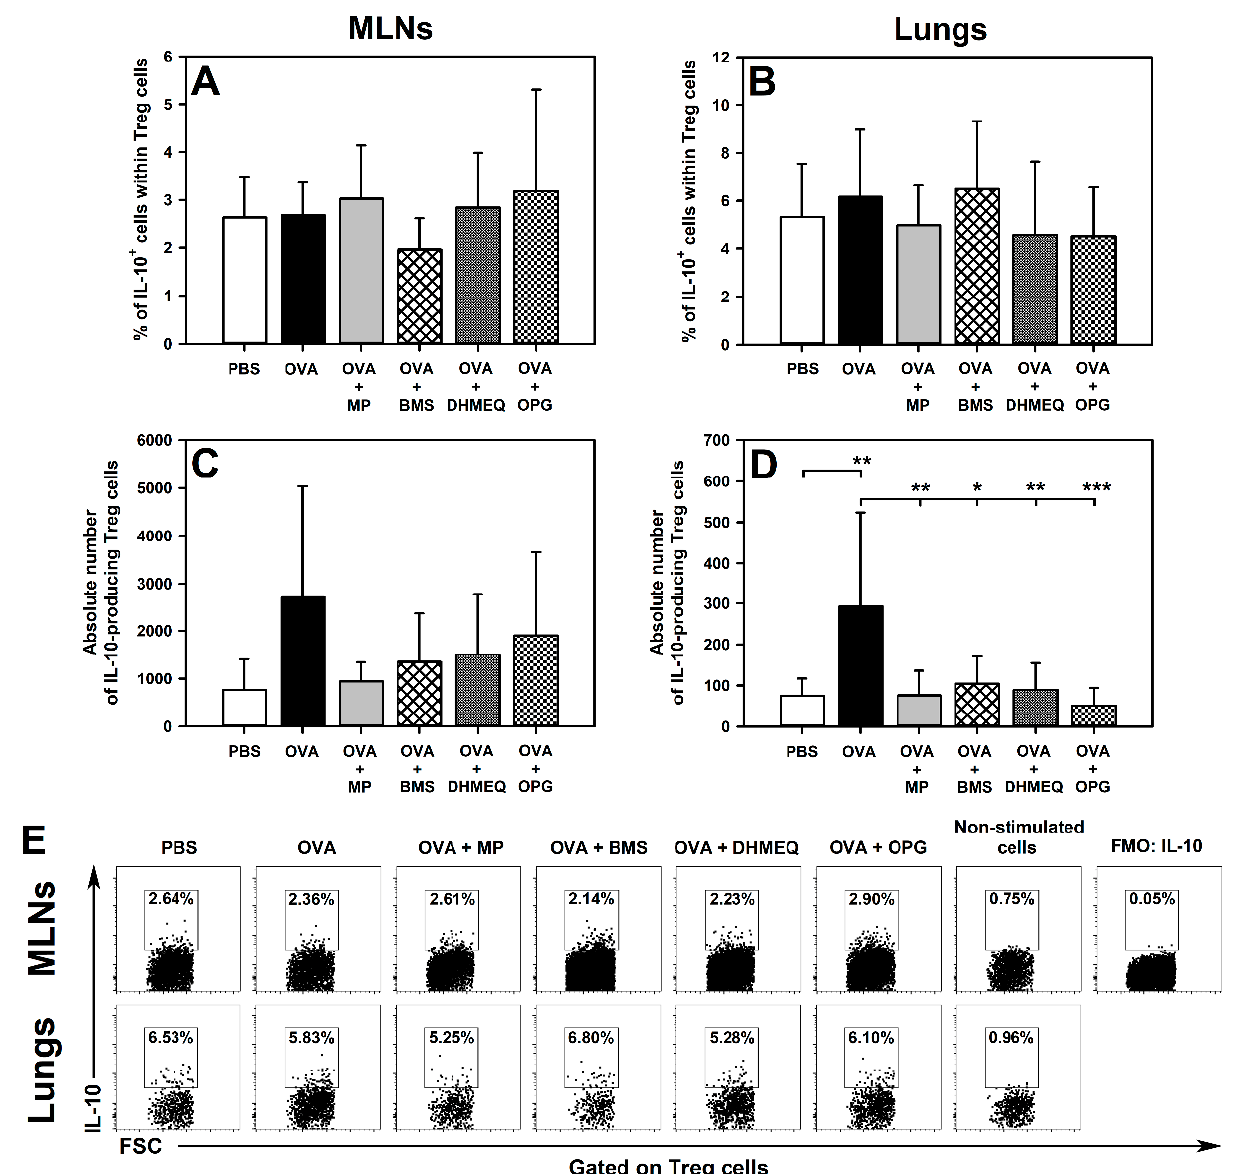
Figure 4. Effect of inhibitors of IKK (BMS-345541 (BMS)), NF- κ B translocation (dehydroxymethylepoxyquinomicin (DHMEQ)) and RANK/RANK-L interaction (osteoprotegerin (OPG)), and glucocorticosteroid (methylprednisolone (MP)) administration on the number of IL-10-producing Treg cells. The relative count ( A , B ) is expressed as a percentage of IL-10-producing cells within Foxp3 + CD25 + CD4 + T cells. The absolute count ( C , D ) represents the number of IL-10-producing Foxp3 + CD25 + CD4 + T cells per MLN or lung sample collected from individual mice. * p < 0.05, ** p < 0.01, *** p < 0.001. Examples of dot plot cytograms showing the distribution of IL-10-producing and non-producing cells within Treg cells ( E ).